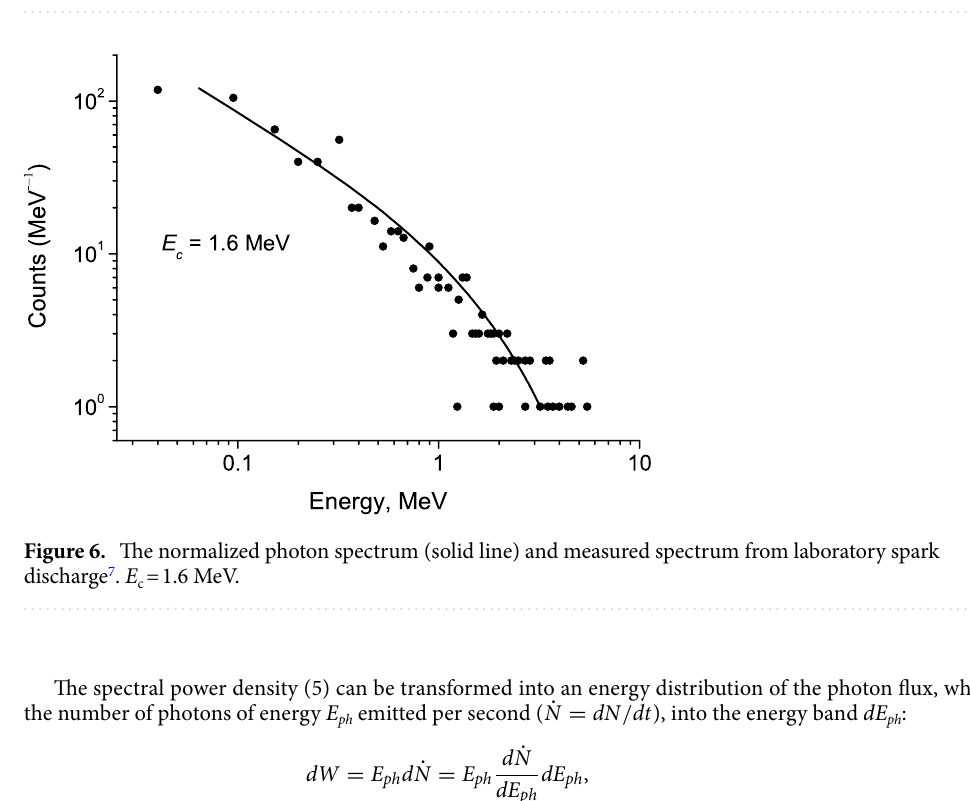
Figure 5. The normalized photon spectrum (solid curve) and measured spectrum from AGILE 13 . E c = 16 MeV.